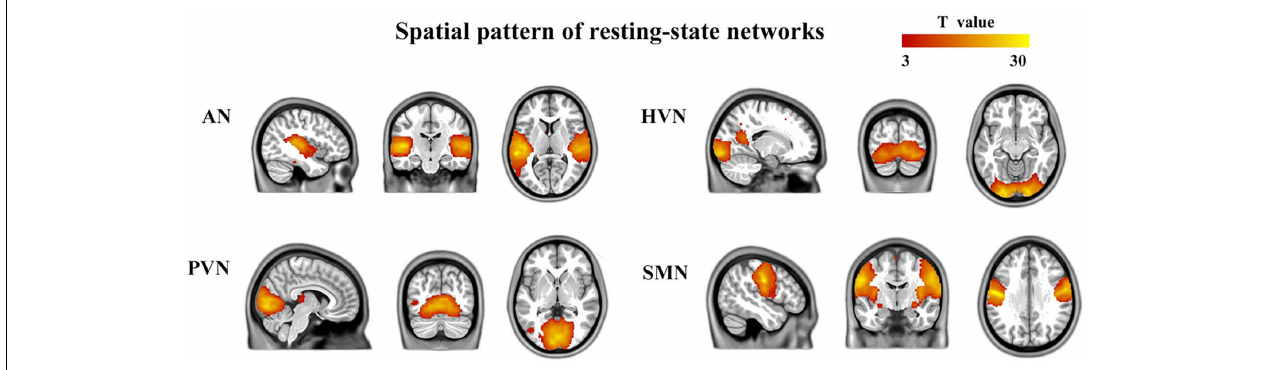
FIGURE 1 | Four brain networks were determined by an independent component analysis. The color bar represents the T- value in each RSN ( p < 0.001, FDR corrected). AN, auditory network; HVN, higher visual network; PVN, primary visual network; SMN, sensorimotor network